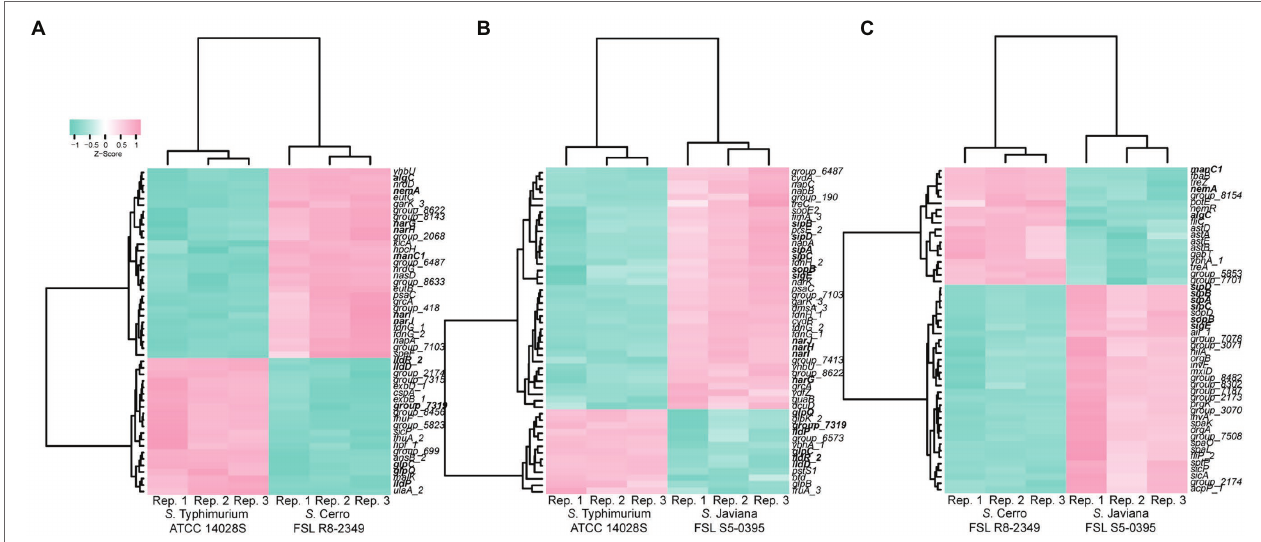
FIGURE 3 | Comparison of transcript abundances in strains grown to late exponential phase in LB reveals many genes and orthologous clusters that are differentially expressed in inter-serovar comparisons. Heat map comparing the transcript abundances of the 50 most significantly differentially expressed (FDR < 0.05, log 2 FC > |2|) orthologous clusters in (A) S. Typhimurium ATCC 14028S vs. S. Cerro FSL R8-2349, (B) S. Typhimurium ATCC 14028S vs. S. Javiana FSL S5-0395, and (C) S. Cerro FSL R8-2349 vs. S. Javiana FSL S5-0395. Differential expression was determined using variance modeling at the observational level (voom method), implemented in the R package limma. Transcript abundances from three biological replicates are shown (labeled as “Rep. 1–3” on the x -axis); z -scores represent the number of standard deviations that each log transformed transcript abundance for a given replicate differs from the average transcript abundances across all repetitions for that orthologous cluster. Clustering was performed using the Ward’s minimum variance method (Ward, 1963) based on Euclidean distance matrices. Genes are shown in bold if transcript abundances are significantly different in multiple comparisons (e.g., sipA shows significantly higher transcript abundances in S. Javiana compared to both S. Cerro and S.